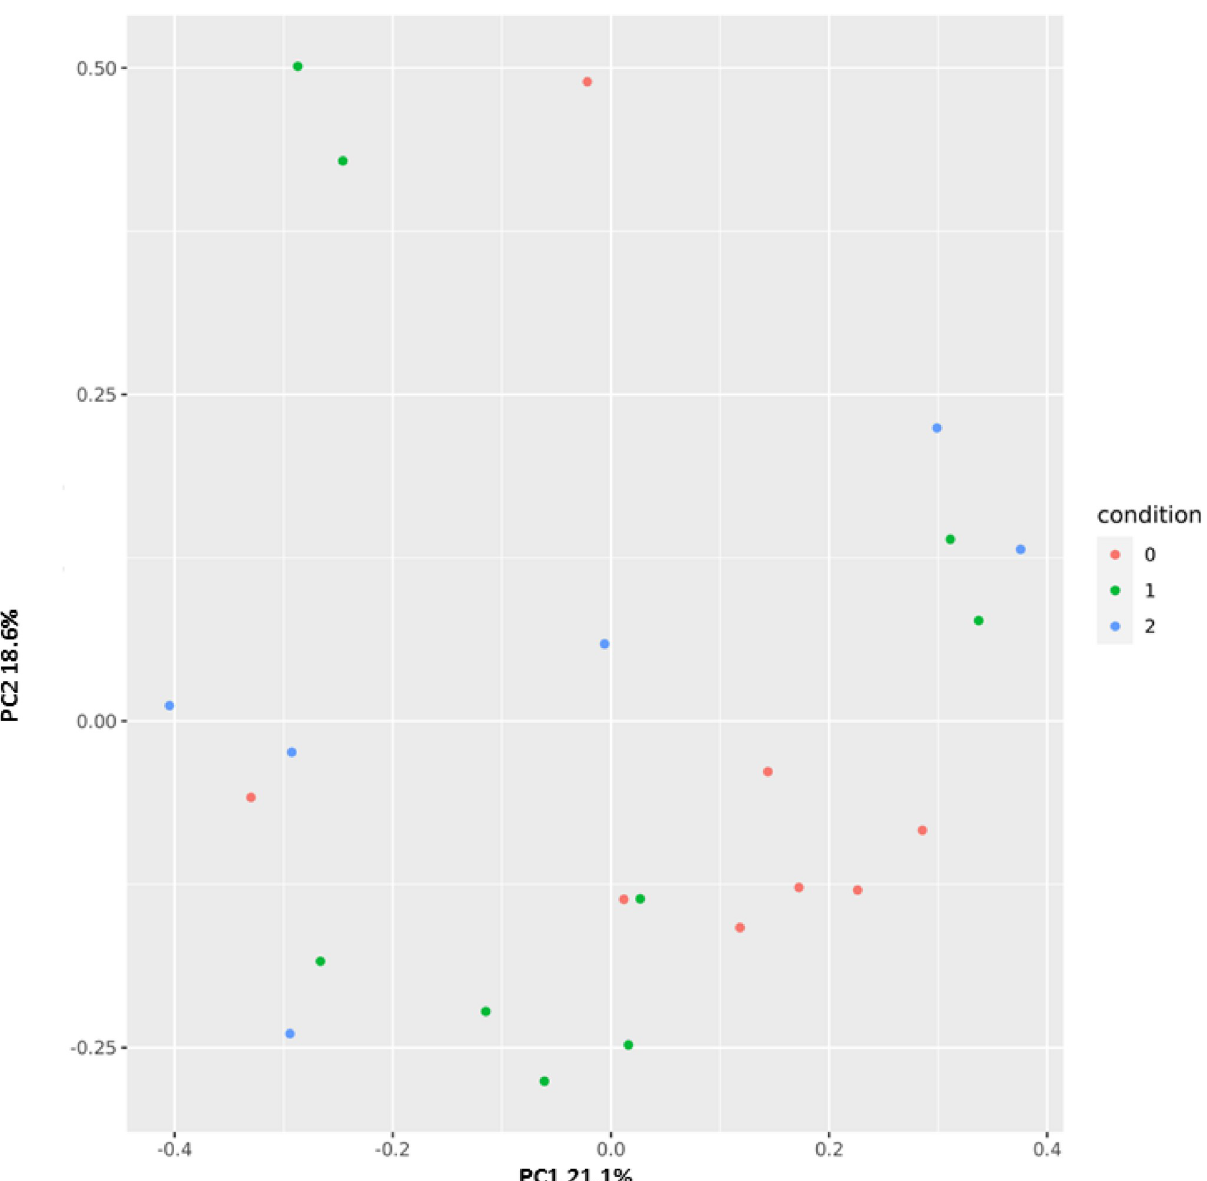
Fig 2. Principal coordinates plot (PCoA) based on Bray-Curtis distances at family level showing a clustering pattern among samples obtained from controls (red), w-COVID19 (green) and i-COVID19 (blue). https://doi.org/10.1371/journal.pone.0247041.g002 PLOS ONE | https://doi.org/10.1371/journal.pone.0247041 February 17,